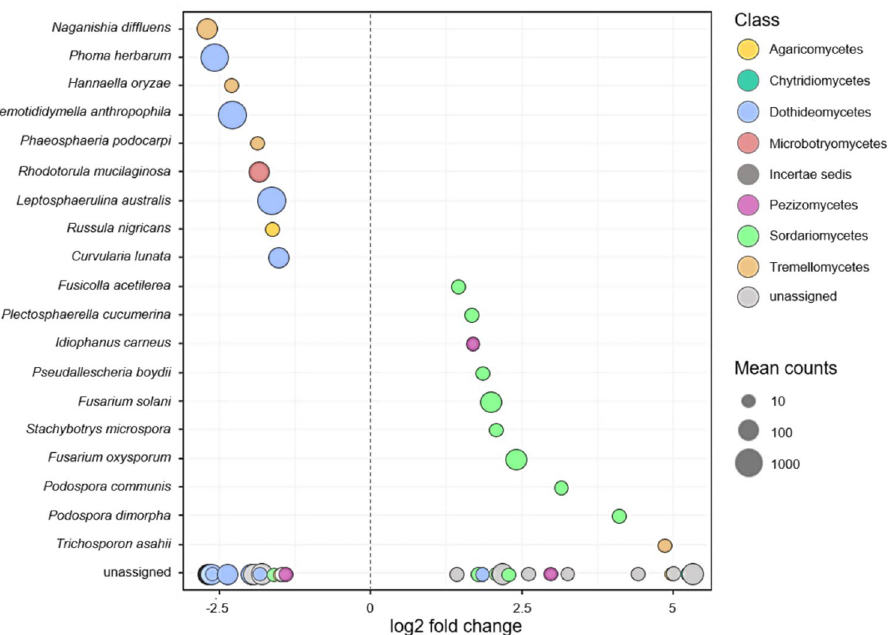
Figure 5. Differentially abundant fungal species of the soil and plastisphere mycobiome identified by DESeq2 analysis. Negative values indicate a significantly (p < 0.05) higher abundance of species on MP. Species are plotted according to their log2 fold change differential abundance and color-coded according to classes. Size factor normalisation was implemented in DESeq2. Bubble size corresponds to the mean read counts across all